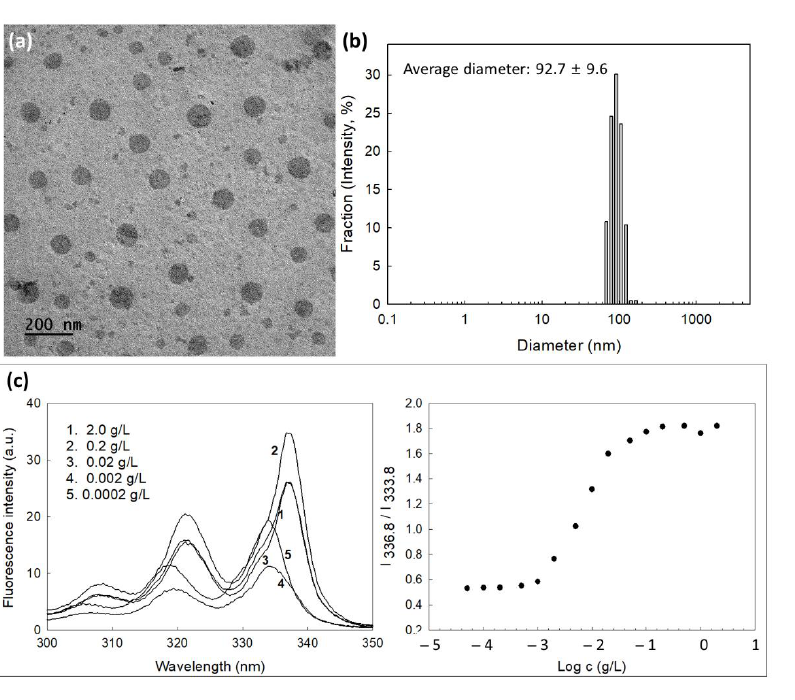
Figure 3. ( a ) Morphological observation of nanophotosensitizers of mPEGseseCe6PBAP conjugates by TEM. ( b ) Typical particle size distribution of nanophotosensitizers of mPEGseseCe6PBAP conjugates. Average particle sizes were mean±standard deviation from five independent analysis. ( c ) Fluorescence excitation spectra of pyrene/mPEGseseCe6PBAP nanophotosensitizers in distilled water (Emission wavelength: 390.0 nm) (left) and I 336.8 /I 333.8 intensity ratio plots from pyrene excitation spectra vs. log c for mPEGseseCe6PBAP nanophotosensitizers in distilled water (right).